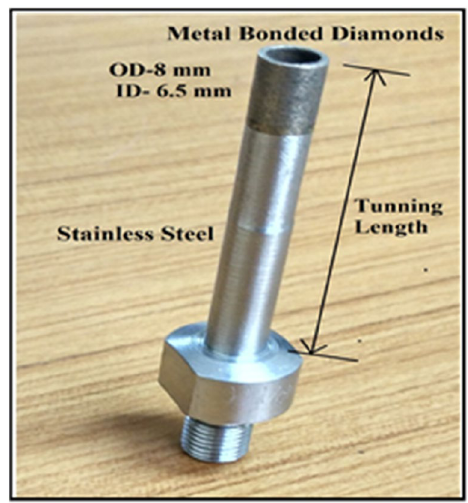
Figure 5. Photographic view of fabricated metal bonded diamond core drill picture.